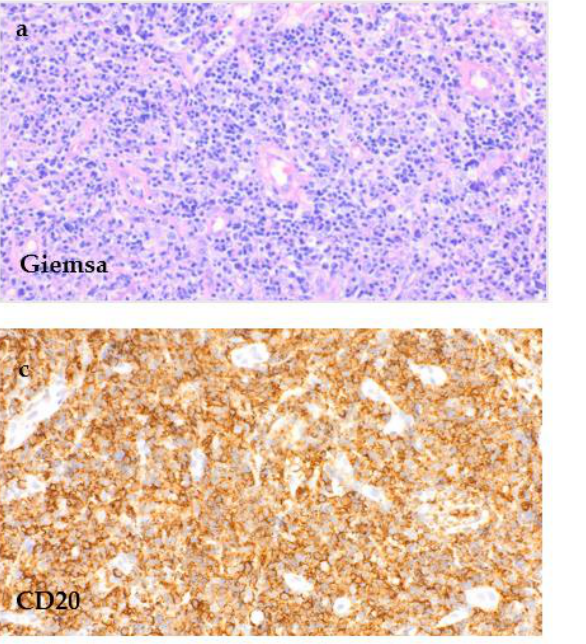
Figure 4. CLL/SLL infiltration of the hypopharyngeal ulcer. Tissue samples of the hypopharynx next to the ulcerated area taken by incisional biopsy, showing a significant number of small lymphatic cells (( a ), Giemsa stain, 100×) with expression for CD20 (( c ), 400×) and co-expression for CD23 (( b ), 400×), reflecting the simultaneous infiltration by the known chronic lymphatic leukaemia.